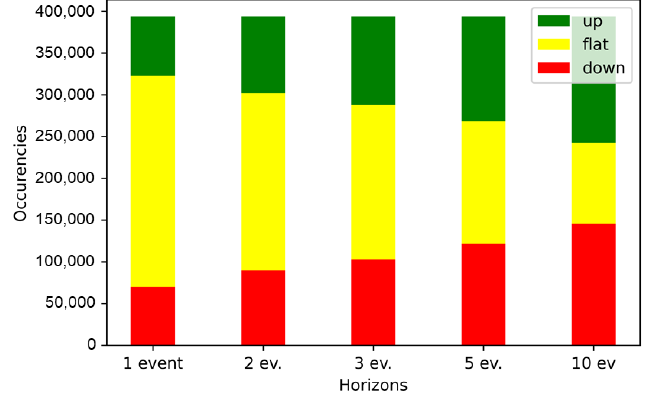
Figure 3. Dataset distribution among three classes of